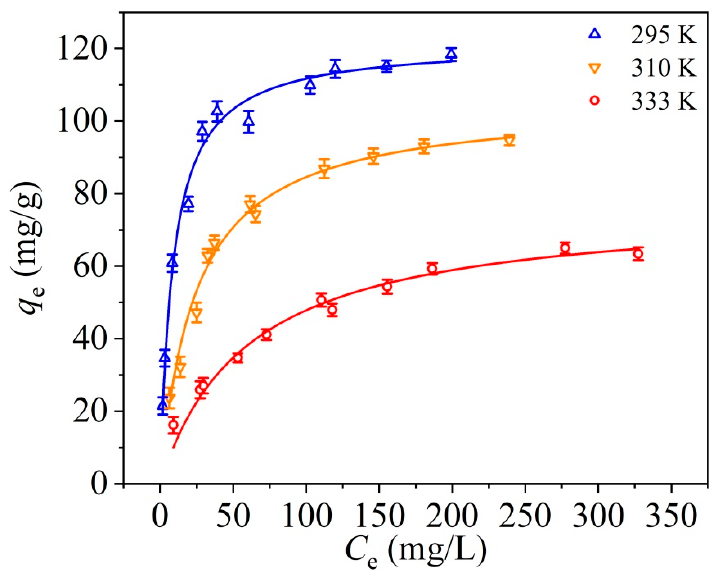
Figure 5. Adsorption isotherm profiles of RBBR retained by UPA( θ ) powders at different temperatures. m/V [UPA( θ )] = 5.56 g·L − 1 , initial pH = 4.0 ± 0.1, I = 100 mmol·L − 1 sodium acetate, stirring speed = 150 rpm, and equilibrium time = 24 h.